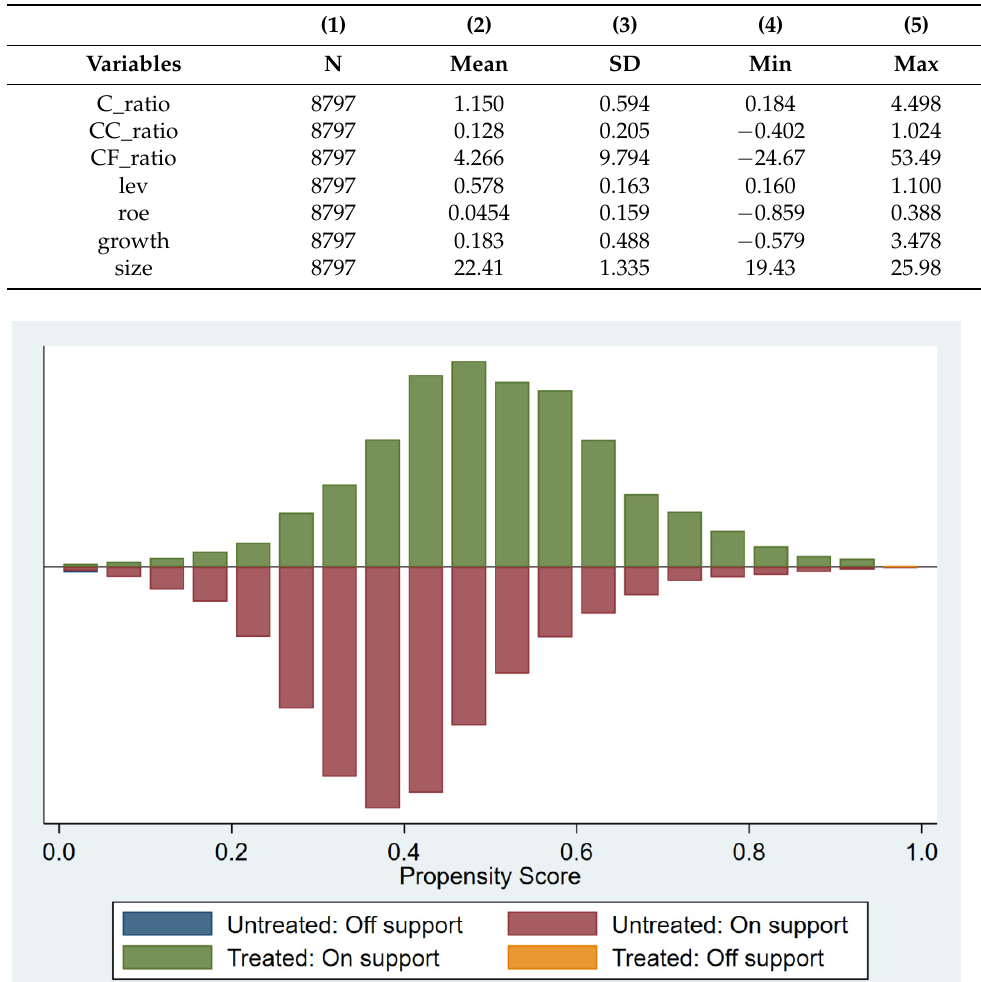
Table 4. Descriptive statistics for each variable.